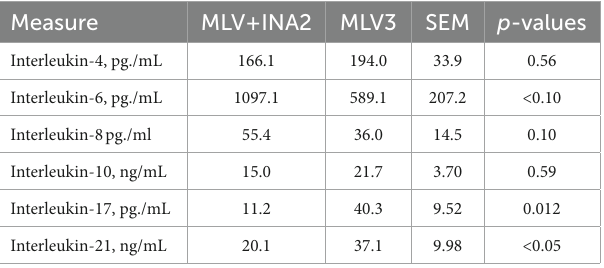
1 Data were log-transformed, but means are non-transformed ± standard error of the mean. 2 Vaccine treatments were MLV + INA = 1 dose of modified-live, 2 doses of inactivated vaccine, and MLV = 3 doses of modified-live vaccine, n = 28